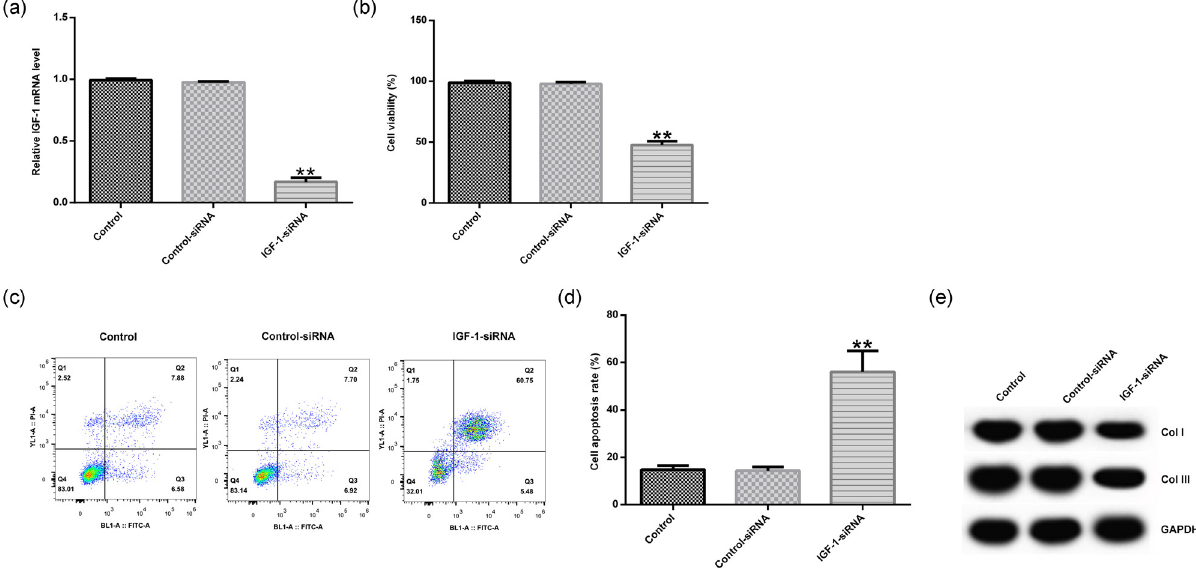
Figure 2: The e ff ect of IGF - 1 siRNA on the cell viability, cell apoptosis, and the protein expression of Col I and Col III in HVFs obtained from POP patients. Control siRNA and IGF - 1 siRNA were transfected into HVFs and then MTT, FCM, and Western blotting assay were used to detect the cell viability, cell apoptosis, and the protein expression of Col I and Col III. ( a ) The e ff ect of IGF - 1 siRNA on IGF - 1 mRNA expression in HVFs. ( b ) The e ff ect of IGF - 1 siRNA on the cell viability of HVFs. ( c and d ) The e ff ect of IGF - 1 siRNA on the cell apoptosis of HVFs. ( e ) The e ff ect of IGF - 1 siRNA on the protein expression of Col I and Col III in HVFs. Data were reported as mean ± SD. ** p < 0.01 vs control